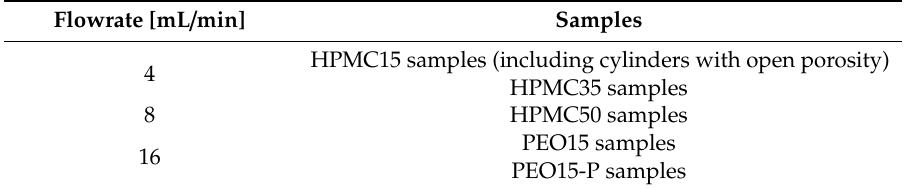
Table 3. Sample-specific flow rates for dissolution testing in flow cell